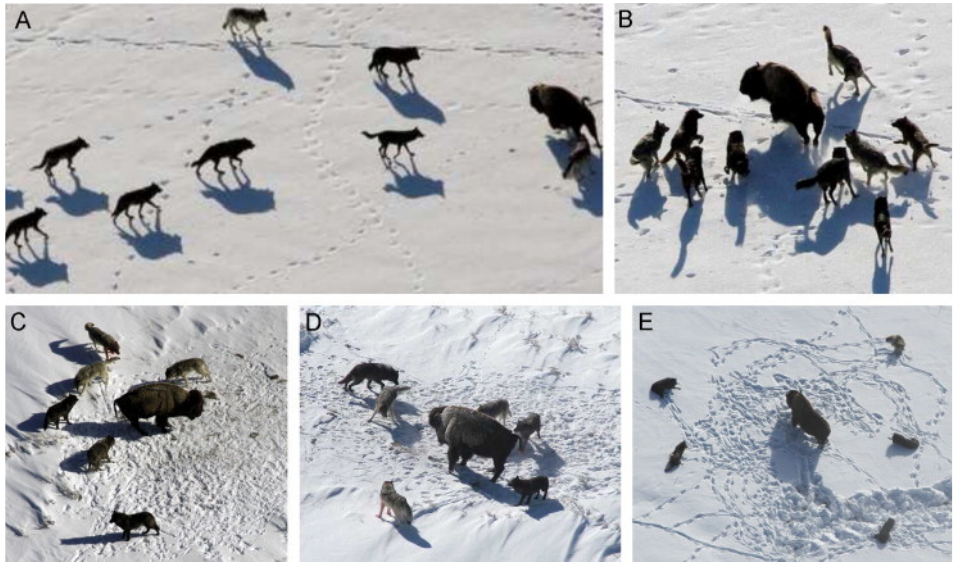
Figure 13. Hunting strategy of grey wolves: ( A ) chasing, approaching, and pursuing the prey, ( B – D ) pursuing, harassing, and surrounding, ( E ) inactive situation and attack [42] (with permission). The steps of the optimization methodology using the Grey Wolf algorithm are shown in Figure 14. The iterations continue to find constant value as the stopping criteria, which are defined by the user. The objective function is the crack width of the one-way slab.